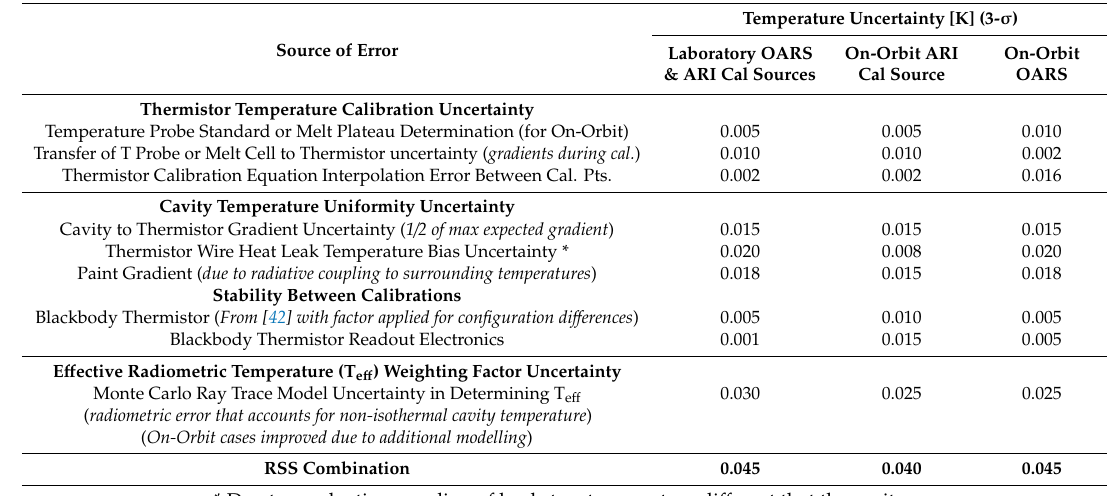
Table 2. ARI calibration source and OARS temperature uncertainty budget. All specified uncertainties correspond to a k = 3 coverage factor. Note that a temperature uncertainty of 0.045 K for the calibration reference blackbodies and the OARS is used in the ARI radiometric uncertainty analysis for all environments. Refer to Siwek et al. [42] for further details on the thermistor